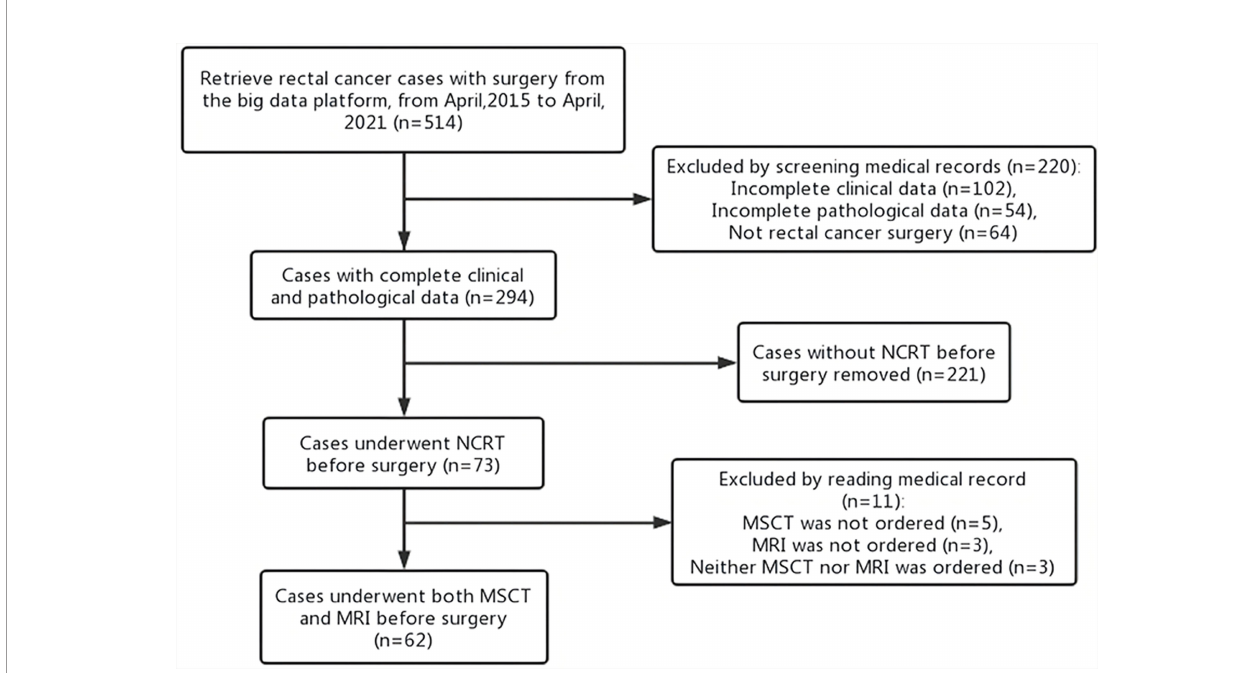
FIGURE 1 | Participant inclusion fl owchart. NCRT, neoadjuvant chemoradiotherapy; MSCT, multi-slice computed tomography; MRI, magnetic resonance